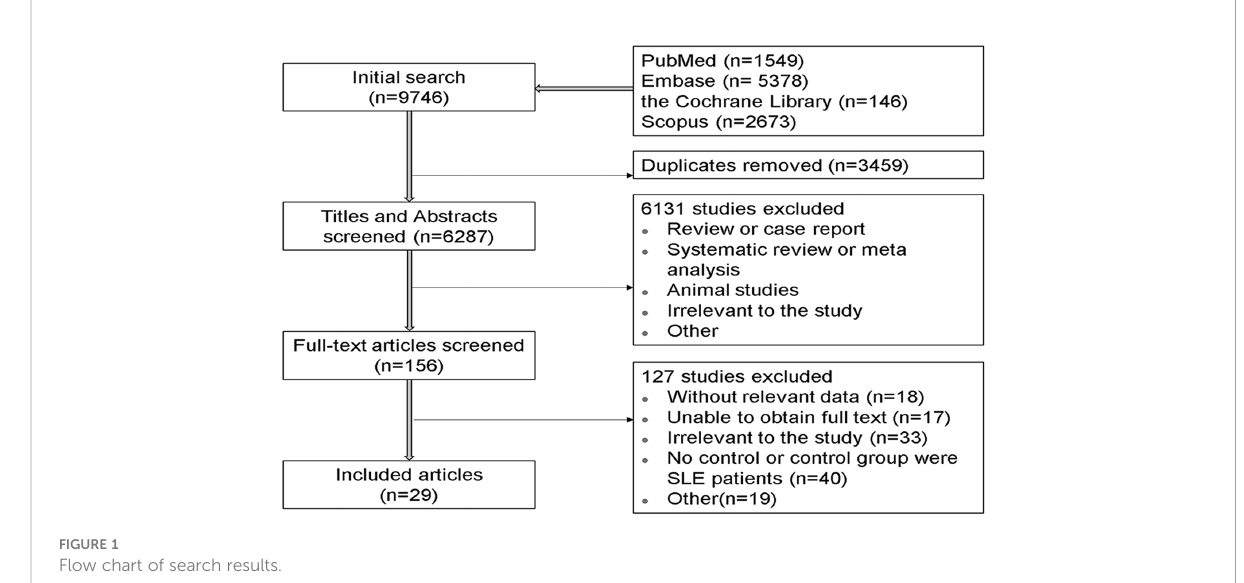
FIGURE 1 Flow chart of search results.